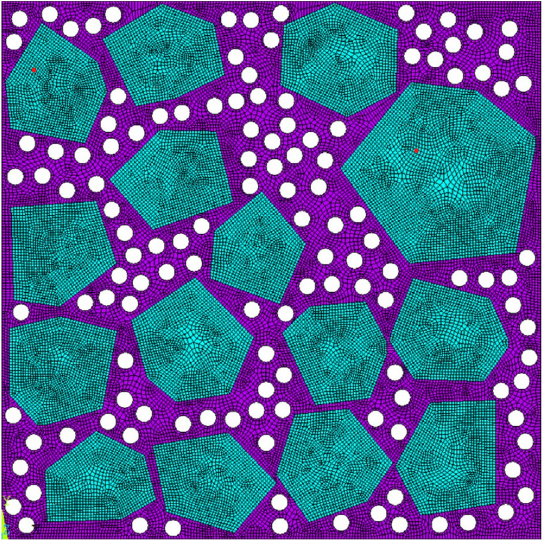
Figure 5. Finite element mesh of the porous PZT composite with the largest volume fraction. Reprinted with permission from ref. [93]. Copyright 2006